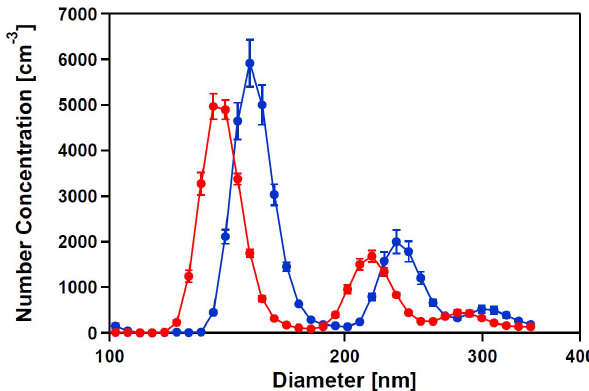
Fig. 4. Size distribution of neutralized, dry particles, electro- Figure 4. Size distribution of neutralized, dry particles, electro-mobility selected at 150 nm, mobility selected at 150nm, before (blue) and after (red) anneal- before (blue) and after (red) annealing at 300 °C in the tube furnace. The particles were ing at 300 ◦ C in the tube furnace. The particles were generated by generated by atomizing a Ca(HCO 3 ) 2 solution. atomizing a Ca(HCO 3 ) 2 solution.